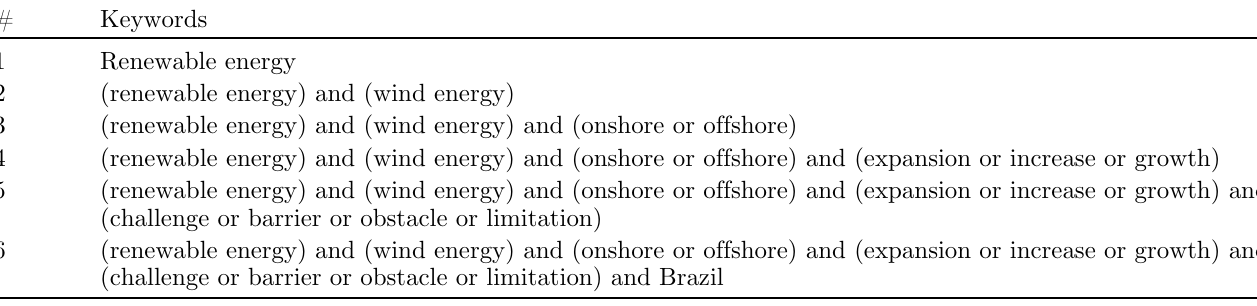
Table 1. List of keywords used in the search platforms.